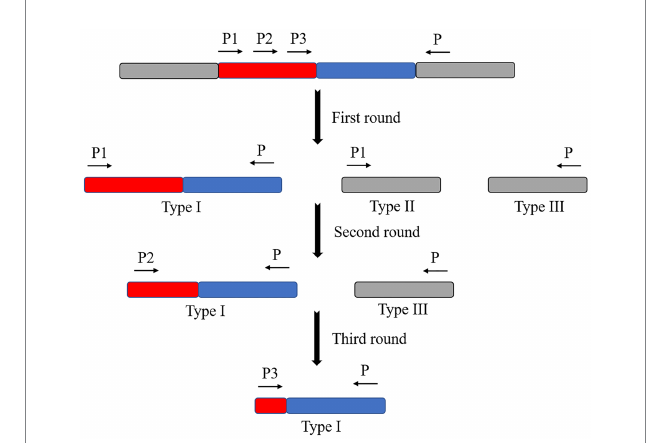
FIGURE 4 Schematic diagram of the TAIL-PCR principle. Three specific primers